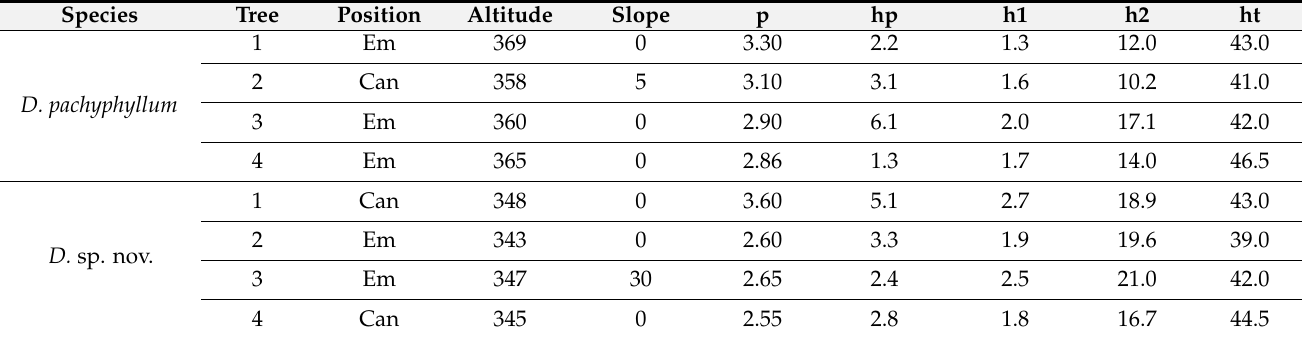
Table 2. Dendrometric and environmental parameters of selected trees. Position: Em = “Emergent” and Can = “Canopy”; altitude (m); slope ( ◦ ); p is stem perimeter (m); hp is the height at which the perimeter was measured (m); h1 is the sampling height at the base of the stem (m); h2 is the sampling height at the top of the stem (m); ht is the total tree height